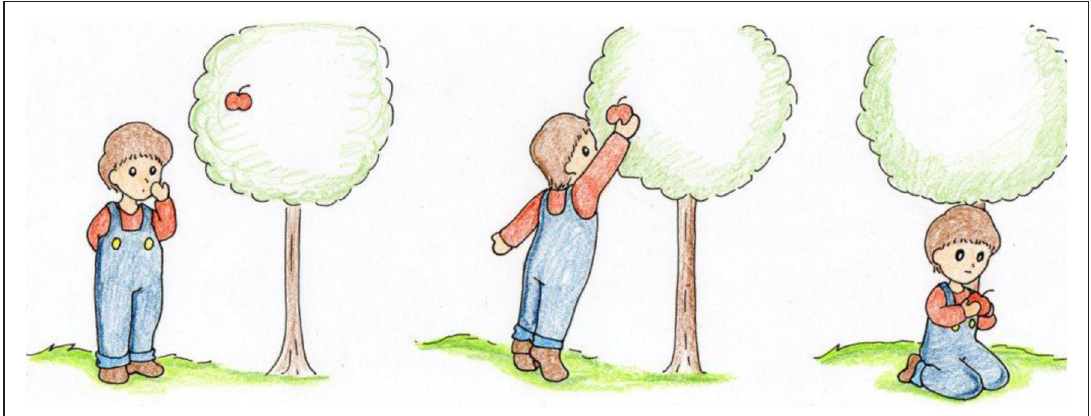
Figure 2: Experiment